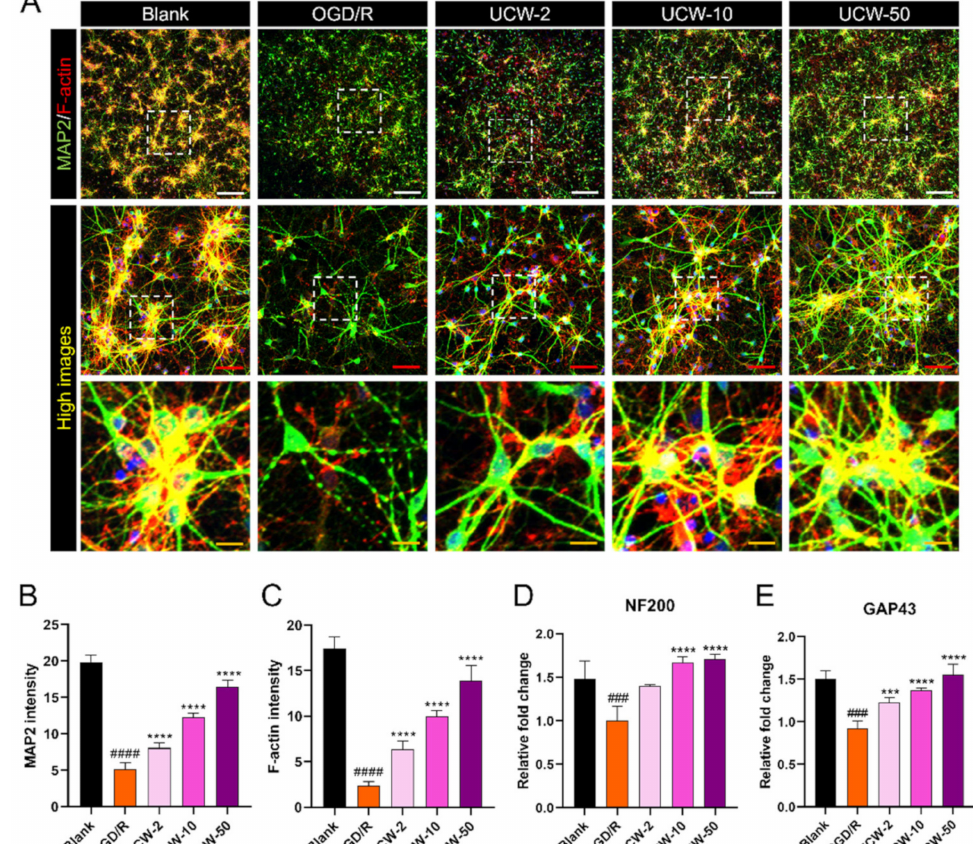
Figure 4. Effect of UCW on neuroprotection against OGD/R-induced injury in primary cortical neurons. ( A ) Representative images of immunocytochemistry for MAP2 (green) and F-actin